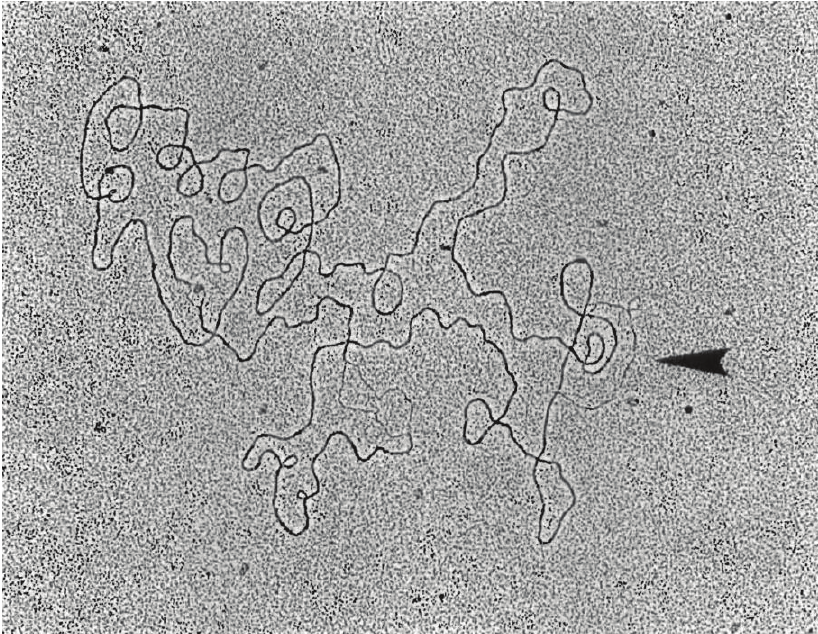
Figure 8. Electron micrograph of a representative λ circular DNA containing a D-loop structure. Electron micrograph of a circular λ DNA molecule showing a region containing a D- loop (indicated by the arrow) obtained from a λ -infected HBT(pOri1) culture. Thick line represents double stranded DNA, whereas thin line, single stranded. Note that the circular DNA shown also has two regions undergoing denaturation (bubble like structures containing two opposite thin lines), a normal occurrence during DNA spreading. These regions are different from the D-loop since this latter structure shows a thick line (double stranded DNA segment) opposite to a thin one.